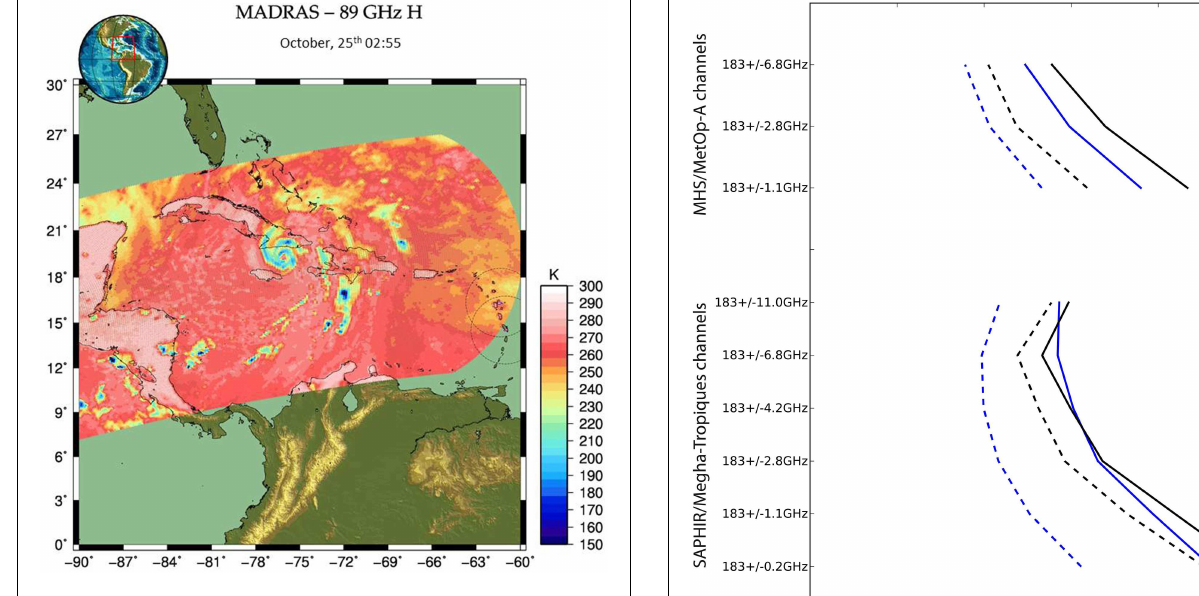
FIGURE 10 | Same as Figure 8 but for the latest available snapshot of Sandy by MADRAS obtained on October 25th, 2012 at 2:55 local time.